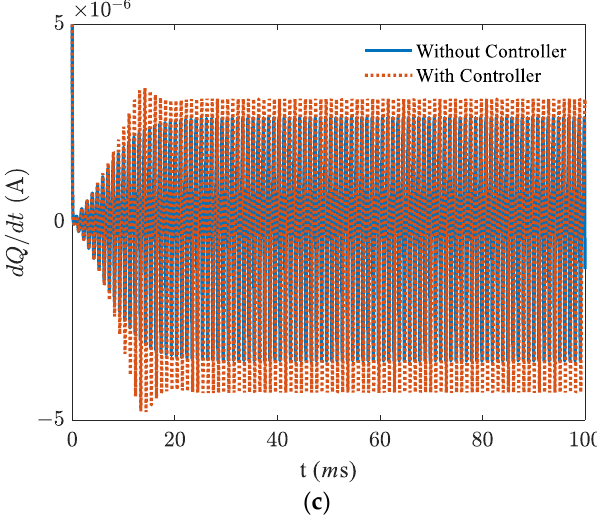
Figure 7. The response in region III, in the presence and absence of the saturation in the PID controller. ( a ) time response, ( b ) feedback signal, and ( c ) current. Figure 8 illustrates the response of the energy harvester in region II as it is exposed to the excitation frequency 𝜔 = 970.8 Hz .